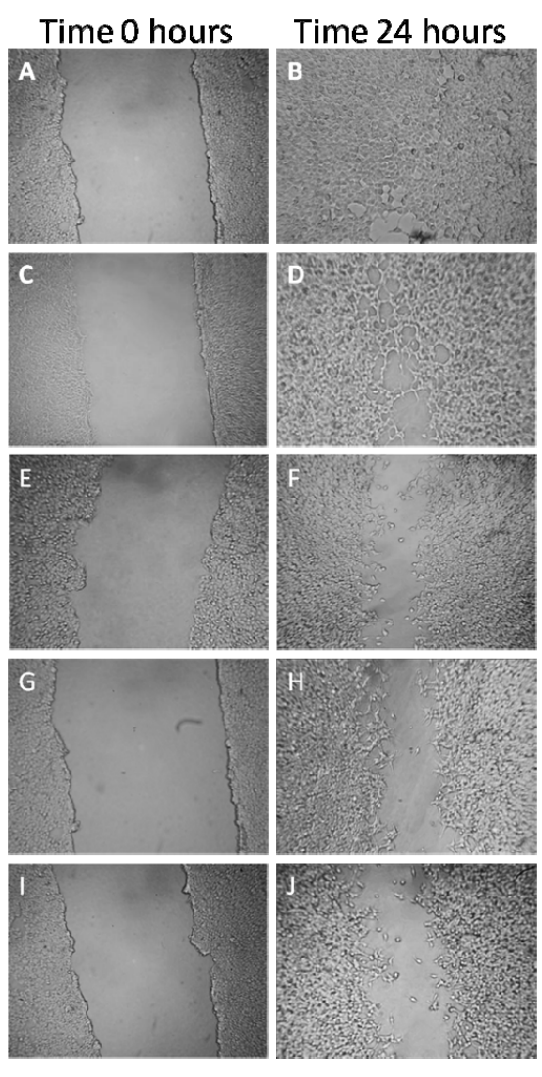
Figure 8. Effects of Cc GCL extract on MDA-MB-231 cells migration. Migration in control conditions ( A and B ); in cells incubated with 35 μ g·mL − 1 ( C and D ); 70 μ g·mL −